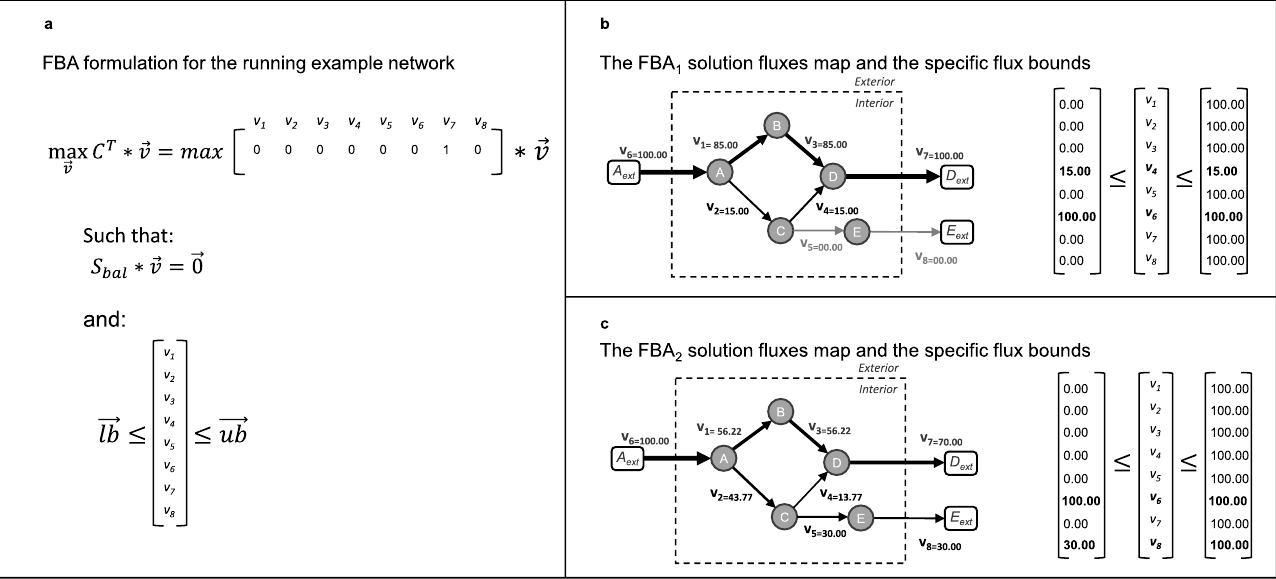
Figure 4. Flux Balance Analysis (FBA) ( a ) The formulation of FBA as a linear programming optimization problem implemented on the running example. v 6 denotes the measured uptake rate and v 7 is the objective flux to be maximized. ( b ) The solution fluxes map (left) for the imposed flux bounds (right). It is assumed that v 4 is measured/known in addition to v 6 ( FBA 1 ). ( c ) The solution fluxes map (left) for the imposed flux bounds (right). It is assumed that v 8 cannot be less than ( nmol ) 30 units ( FBA 2 ). Units: Flux rate units such as or mmol gDW − hr 1 e 6 cell − hr